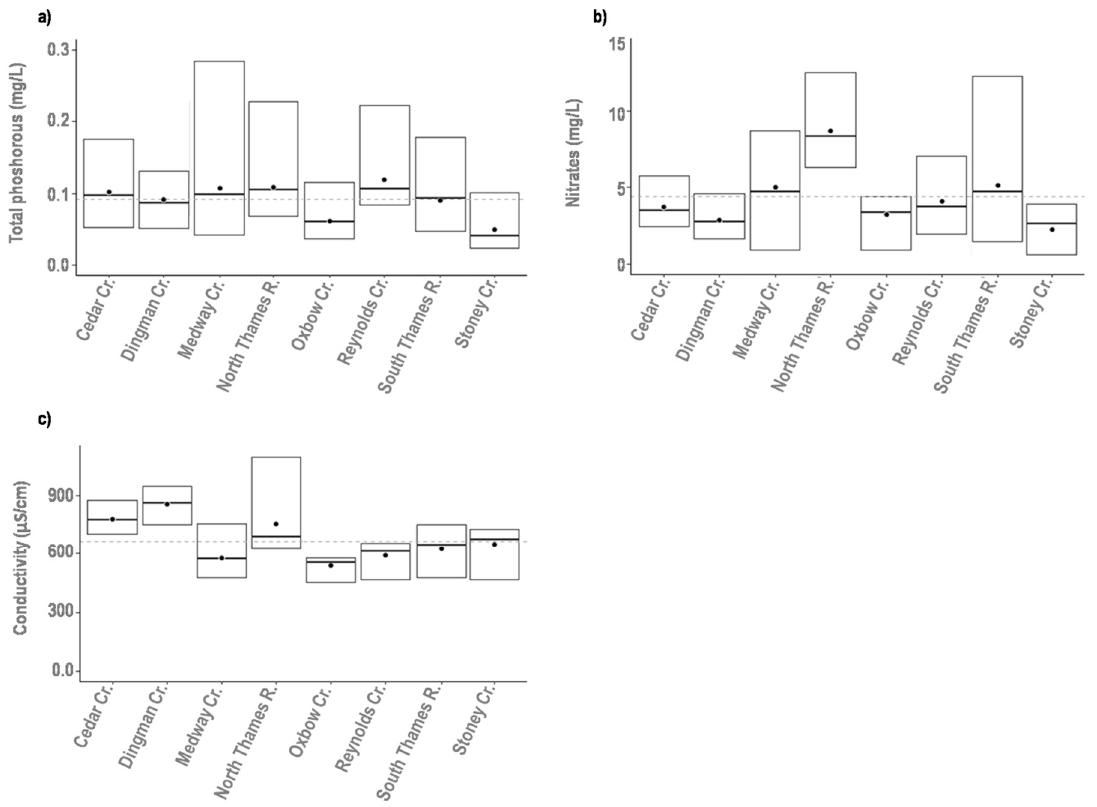
Figure 5. Box plots summarizing mean annual values of total phosphorus ( a ), nitrate ( b ) and conductivity ( c ) sampled five to seven times annually in eight rivers in the Upper Thames River Basin (southern Ontario, Canada) monitored for at least 10 years. Bars represent range of values, solid black lines represent median values, and black circles represent means. Gray dashed line indicates the mean of all streams combined.